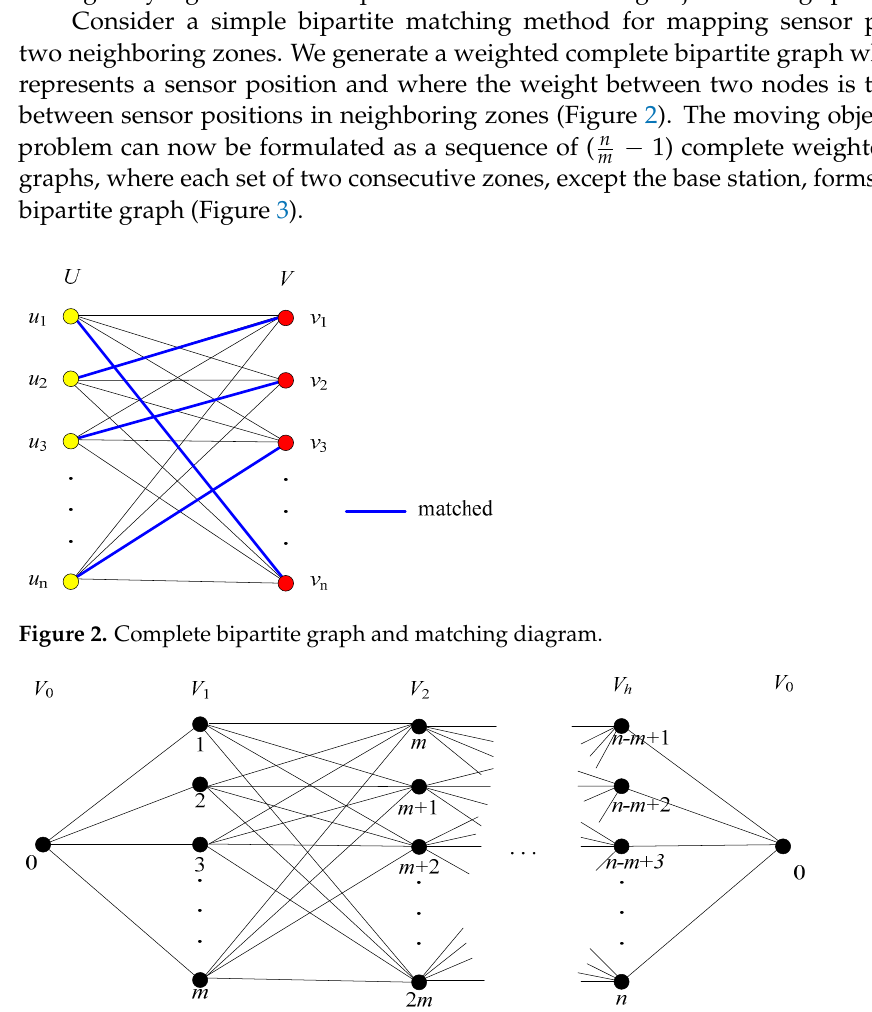
Figure 3. Illustration of a sequence of complete bipartite graphs in the moving object coverage problem.